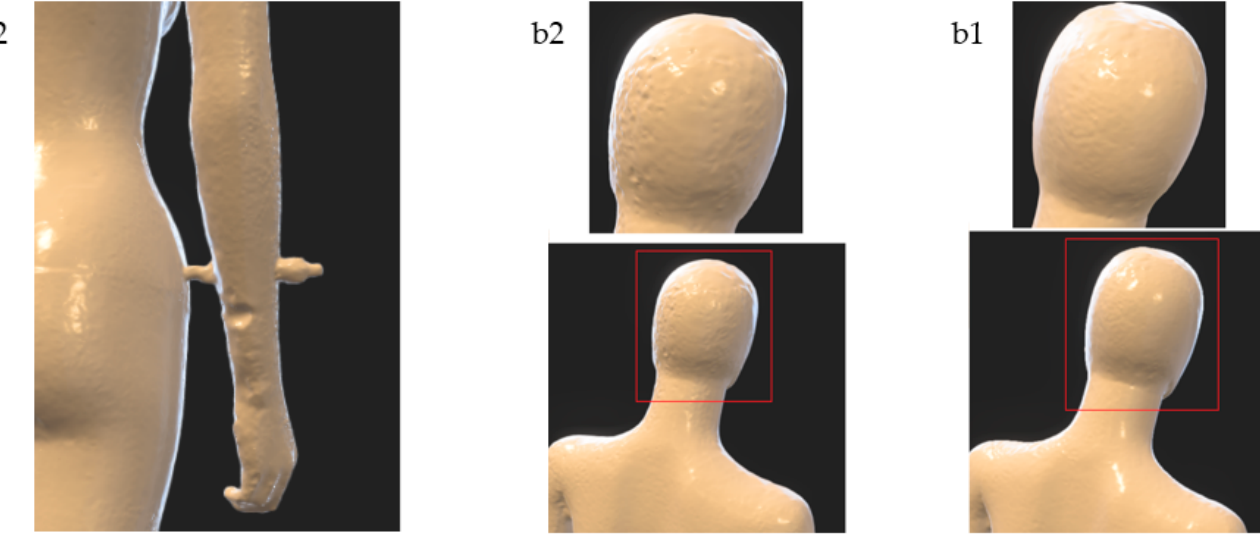
Figure 12. Selected characteristic fragments of 3D models for variants b1 and b2. Details in red rectangles are shown magnified.